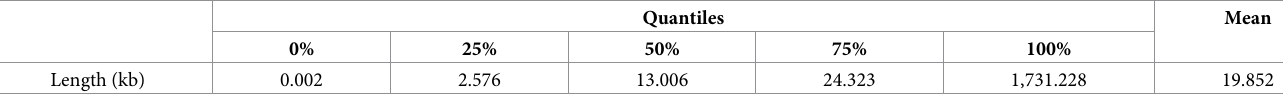
Table 1. Summary statistics of the lengths of CADD